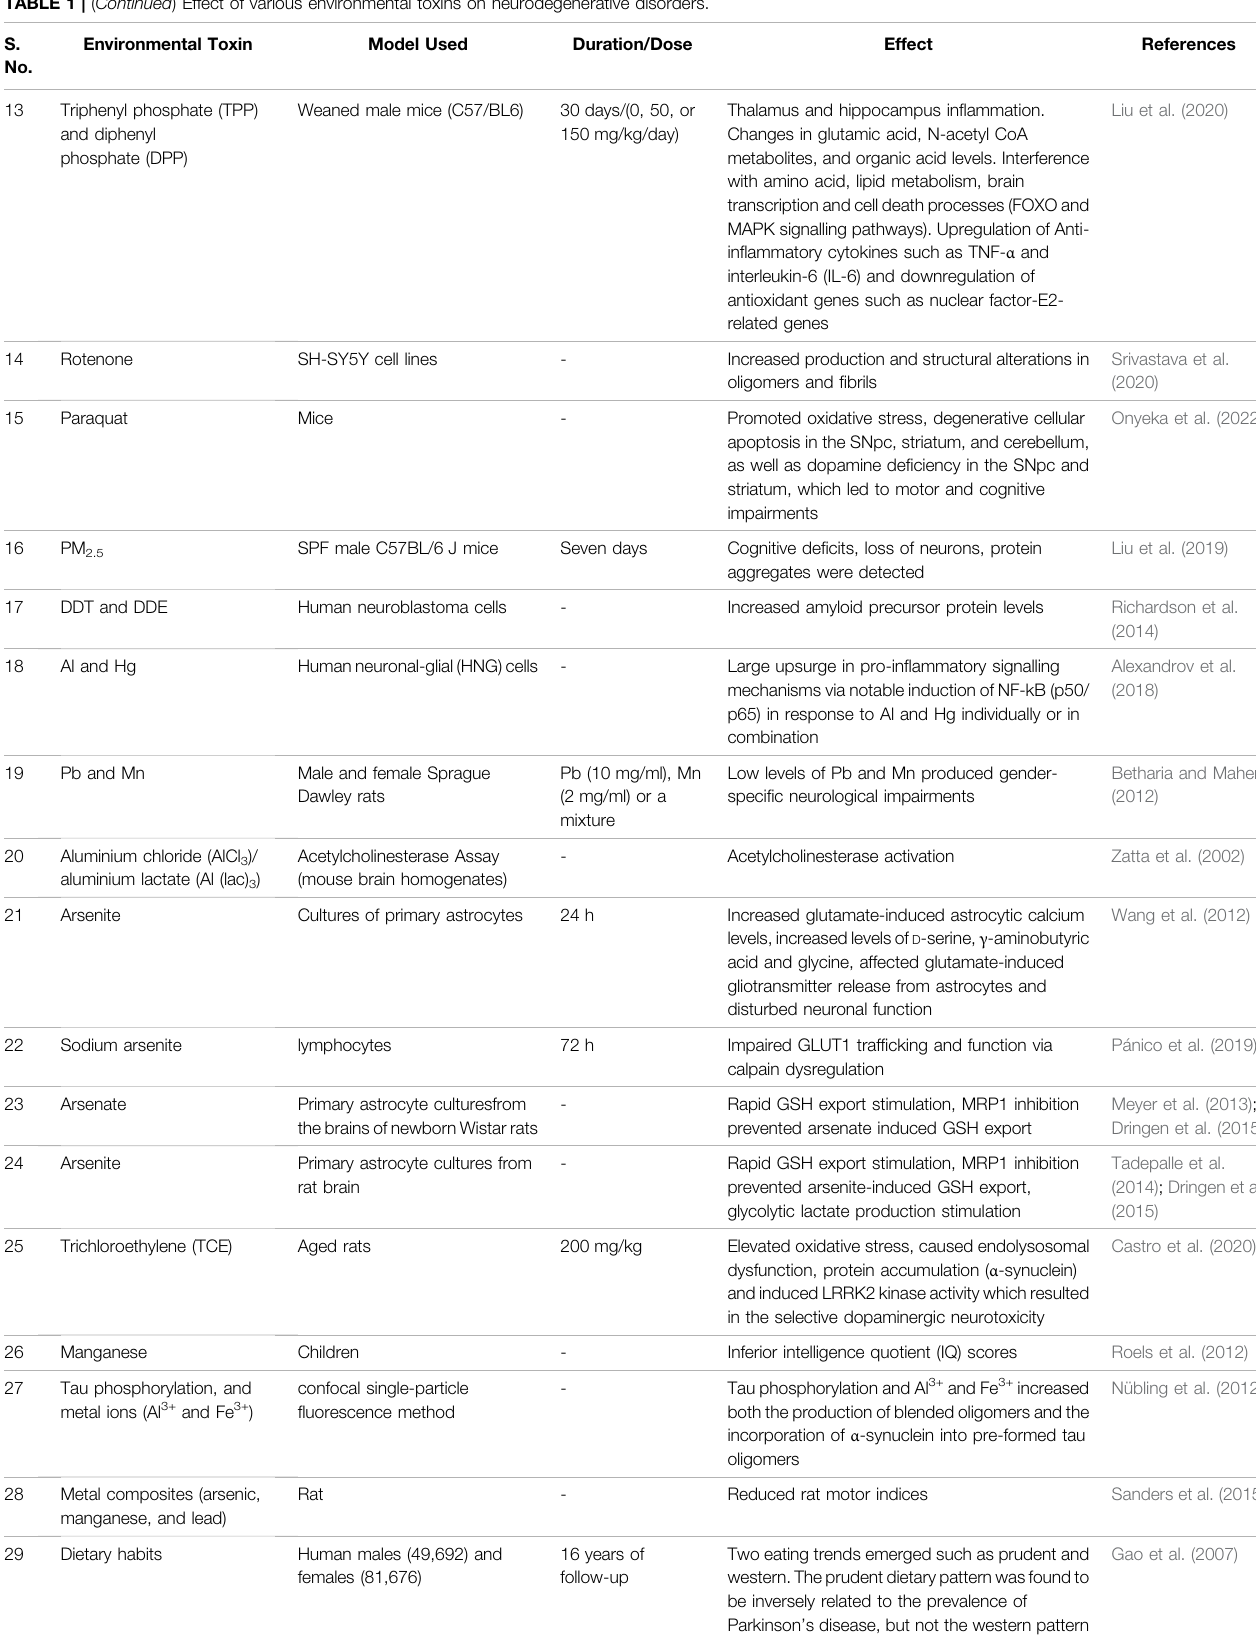
TABLE 1 | ( Continued ) Effect of various environmental toxins on neurodegenerative